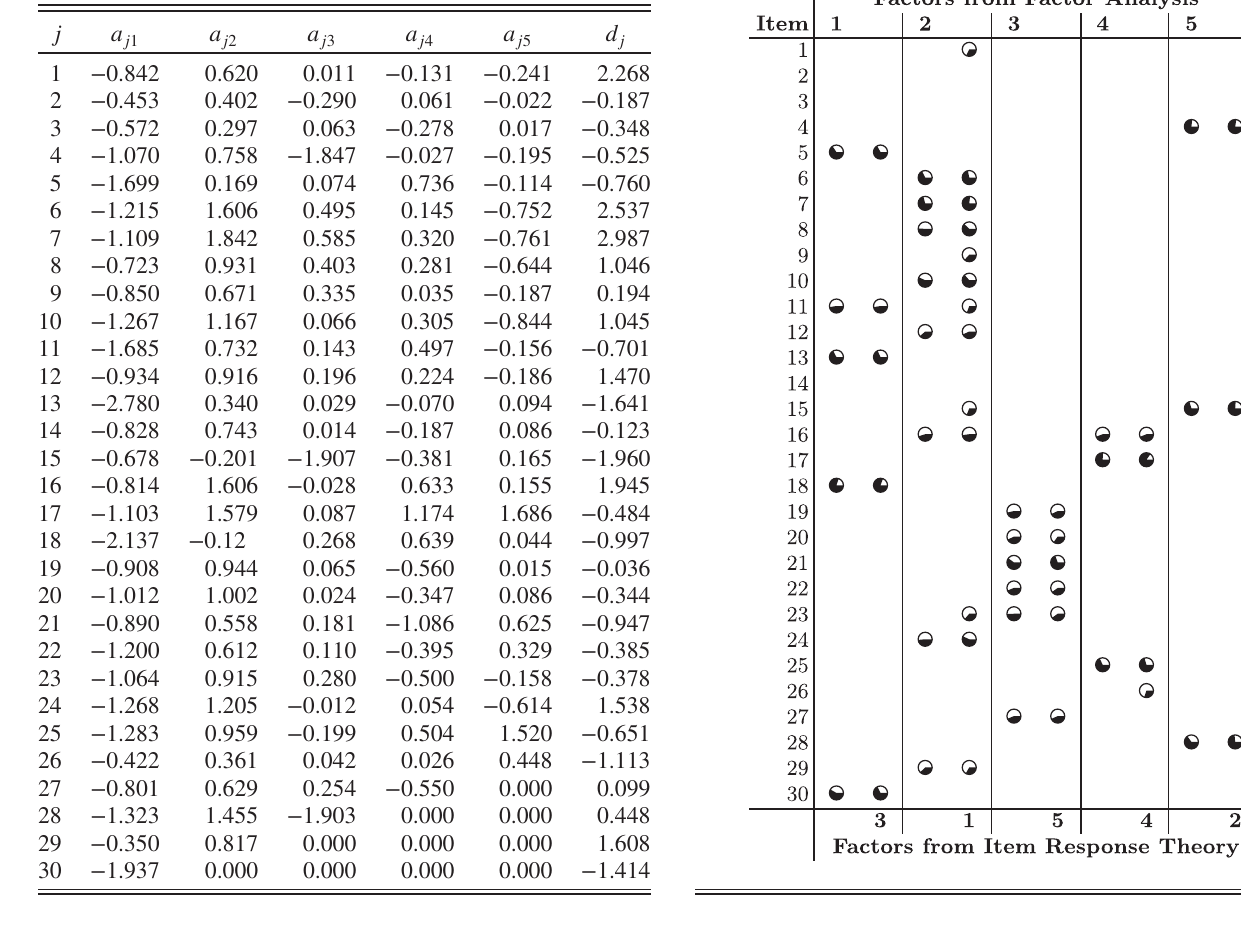
TABLE IV. The members of all five factors as obtained [13] from factor analysis (top row) and as given independently from item response theory (bottom row). The symbols show which item belongs to which factor with loading larger than 0.3 in magnitude. If no symbol can be found in a row then that item TABLE III. The fitting parameters, the five discriminating either has not been assigned to a factor or its loading is smaller ; … ; a parameters a , and the difficulty parameter d of item j 1 j 5 j then 0.3 in absolute value. The black portion within each circular j , for all 30 items in the FCI test with the five-trait model. As a shape is proportional to the ; … ; a reminder, we note here that the individual a values j 1 j 5 cannot directly be compared to the a values in Table II (see j Sec. III for a detailed explanation).